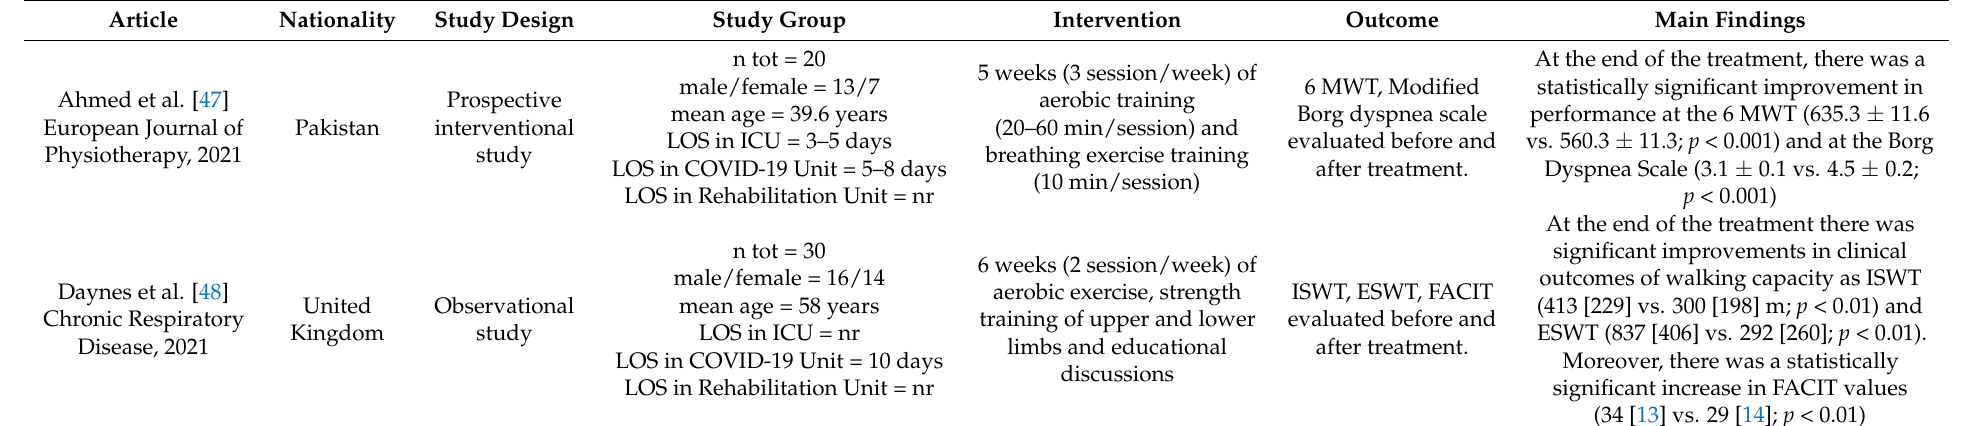
Table 4. Main findings of the included studies (observational